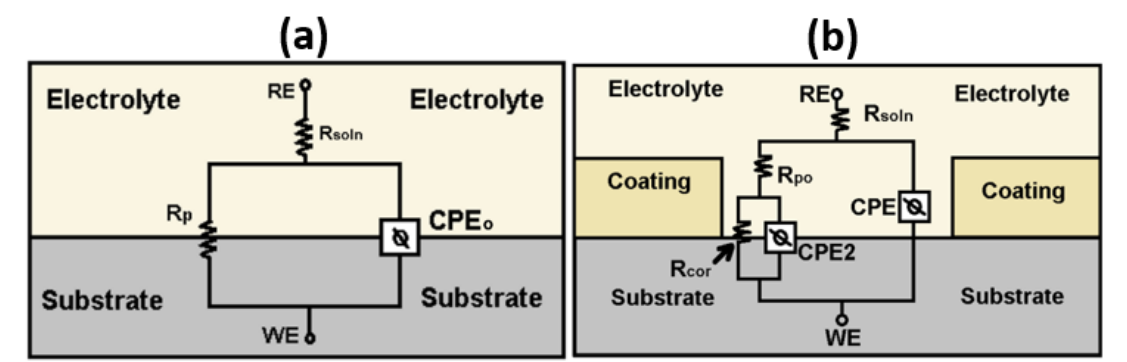
Figure 8. Nyquist spectra for the 316L substrate and the ZrN, ZrN+1Ag, and ZrN+2Ag coatings at ( a ) 1 h of immersion and ( b ) 216 h of immersion.